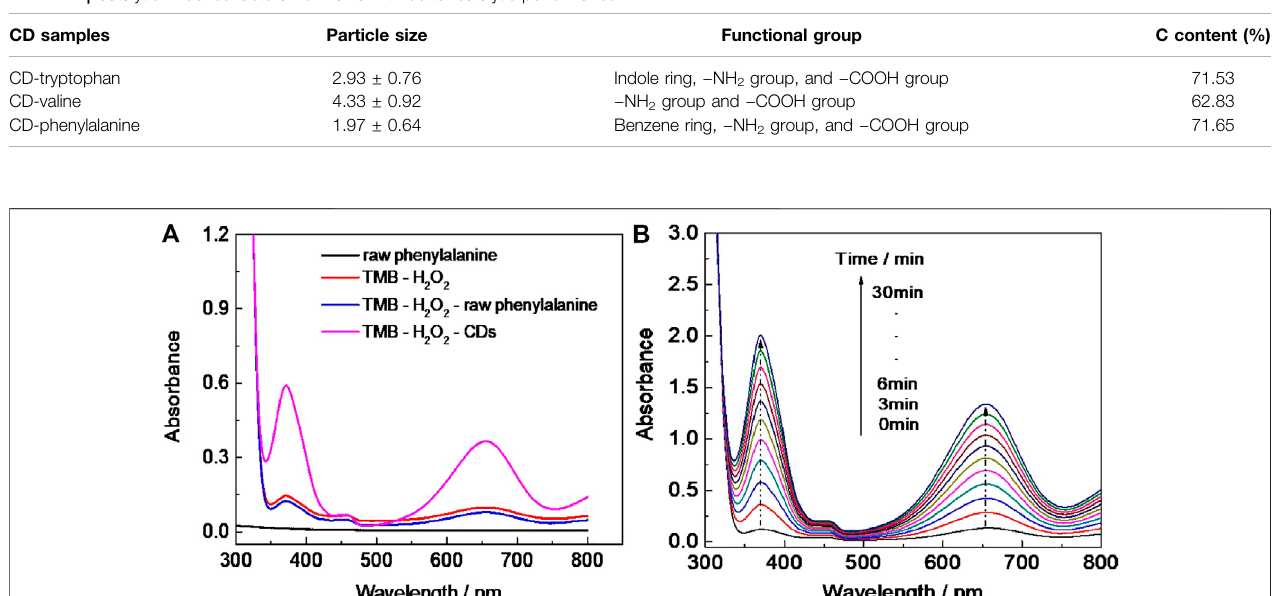
FIGURE 3 | (A) UV – vis absorption spectra of the different reaction systems (reaction time (cid:2) 5 min). (B) Time-dependent UV – vis absorption spectra of the TMB –